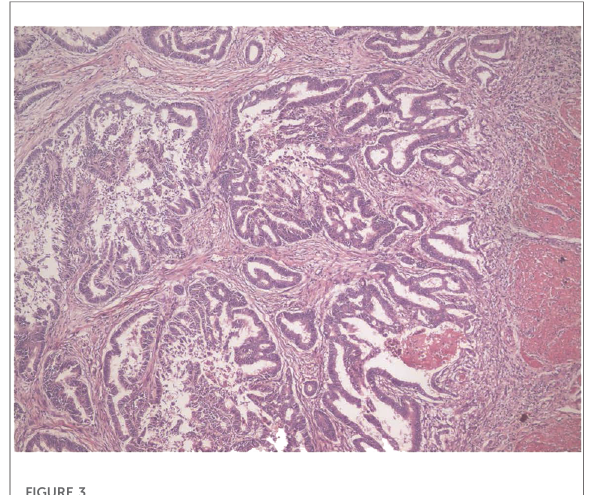
FIGURE 3 Histopathology specimens of adenocarcinoma of the duodenal